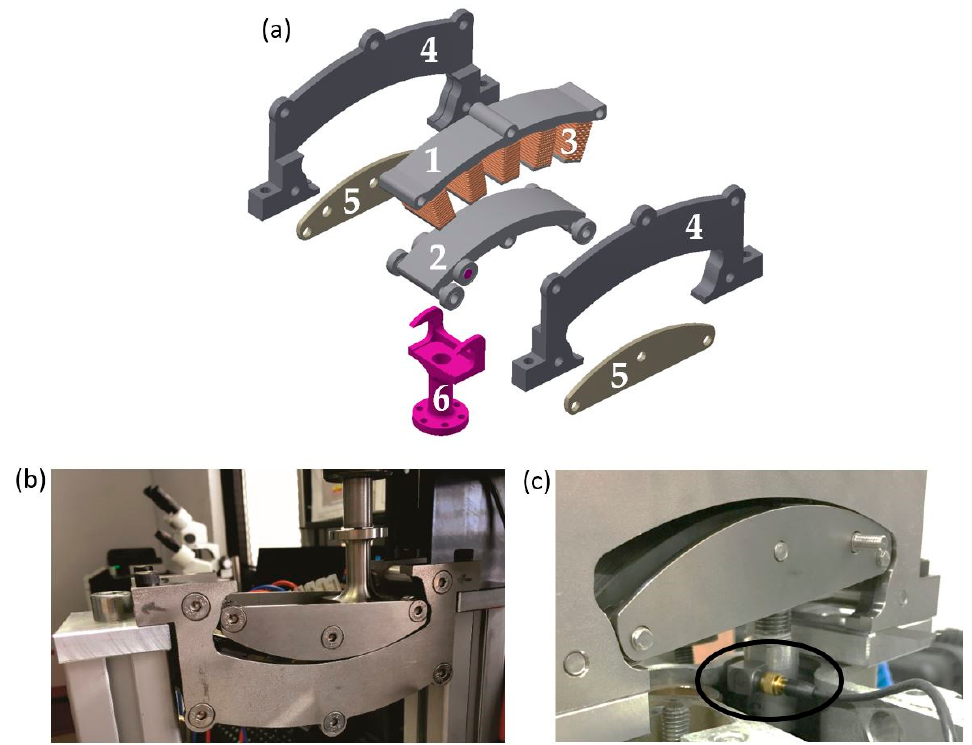
Figure 9. ( a ) The exploded view of the prototyped actuator composed of the following components: 1. stator, 2. mover, 3. coil winding (on the stator poles), 4. stator cradle (stationary component), 5. mover cradle (movable–rolling component) and 6. output component (the connecting part to the valve); ( b ) actuator and its cradles / housing during the experimental force measurements; and, ( c ) the actuator mounted on the valve of single cylinder engine with the accelerometer.